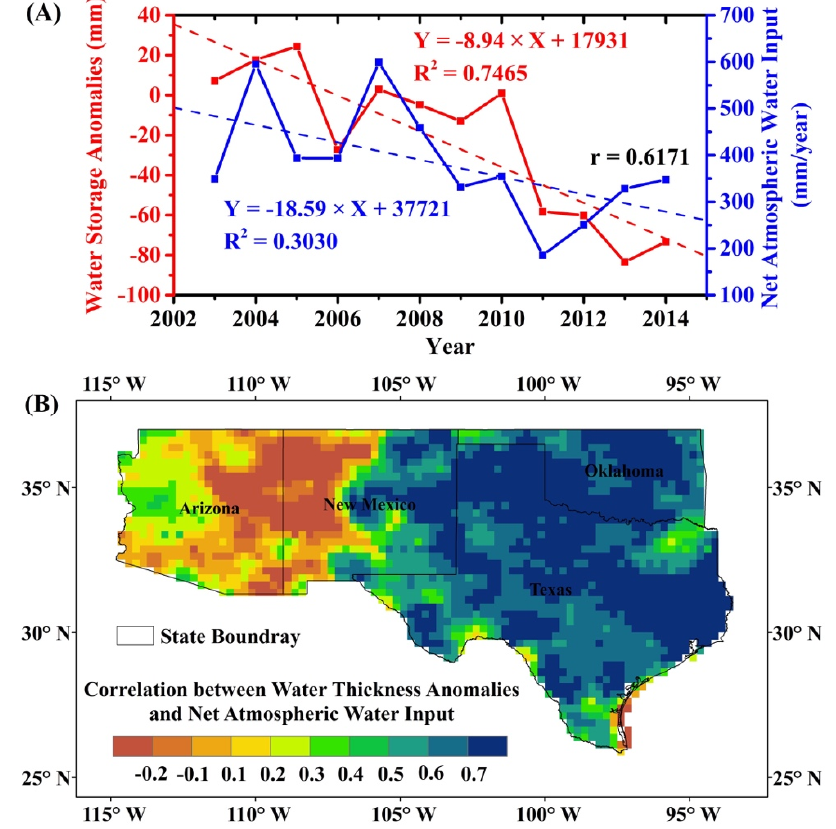
Figure 4. Temporal correlation between annual net atmospheric water input and annual water thickness over the SWUS from 2003 to 2014 (( A ) temporal correlation of average across entire SWUS; ( B ) spatial distribution of the temporal correlation).